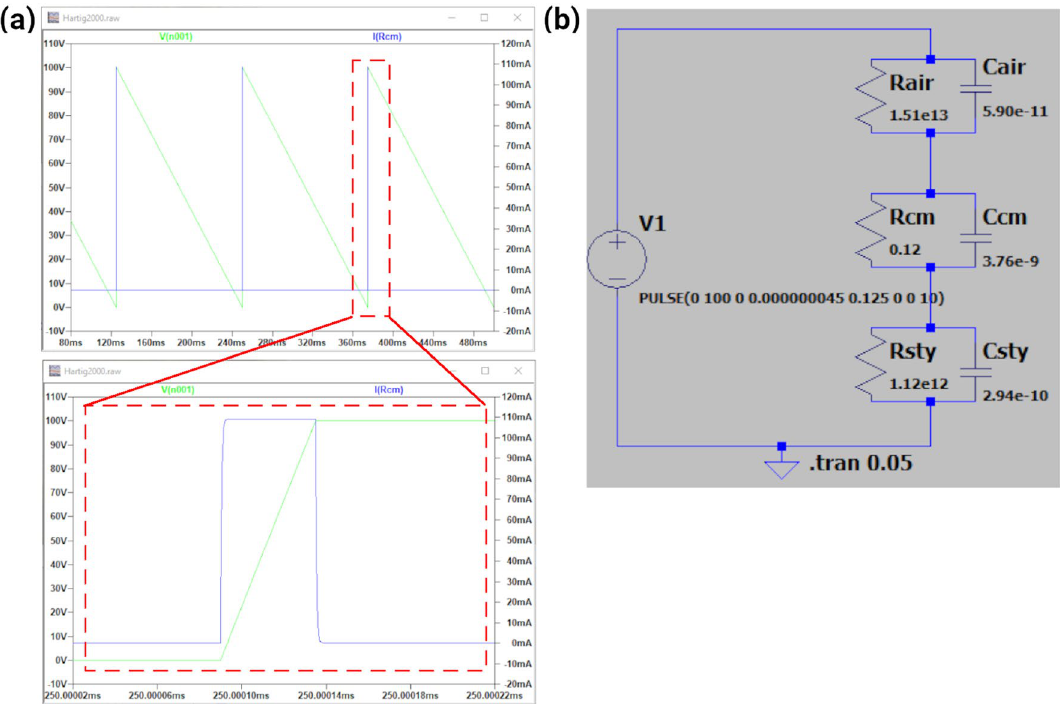
Figure 4. Example of LTspice analog circuit simulation for Hartig’s et al. setup 17 . Printscreens from the software environment: ( a ) digital probe tool visualizer showing the input potential signal (green line) and the electric current peak generated in the culture medium resistor (blue line). The bottom panel shows a detailed view of the rising edge for better visualization of the induced current; ( b ) Equivalent circuit model of Hartig’s setup drawn in LTspice. Abbreviations: R-resistor, C-capacitor, cm-culture medium, sty-polystyrene, V1-voltage source.